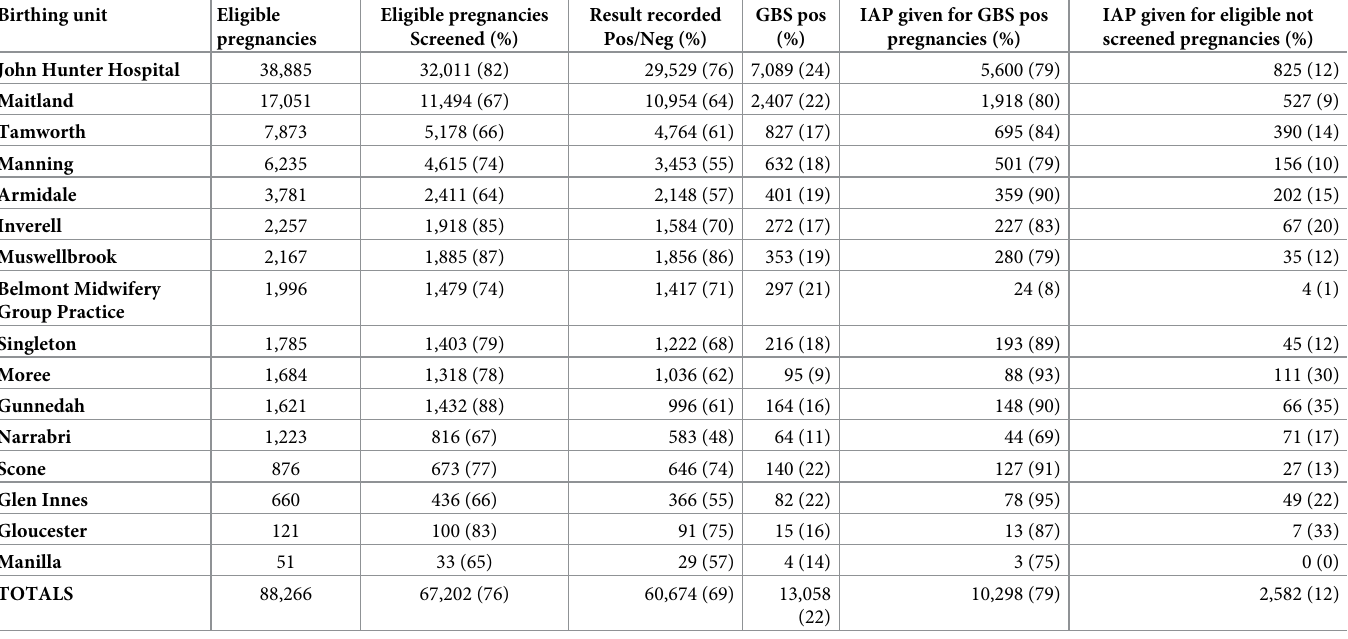
Table 2. Eligible pregnancies, maternal GBS screening and colonisation rates, and IAP provision.